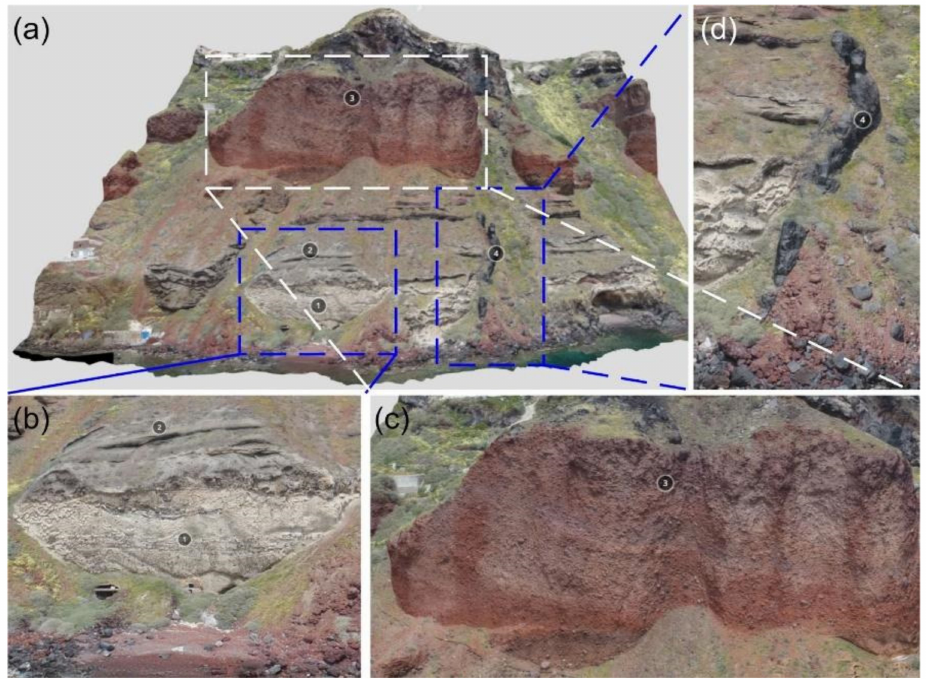
Figure 11. ( a ) A northern caldera wall outcrop close to the Oia village. ( b ) A closer look of the contact between the rhyodacitic pyroclastic deposits and the less evolved ones (andesitic to dacitic), ( c ) a view towards the north of the US2 deposit, and ( d ) a basaltic andesitic dike with a variable dip that dissects the products of the second explosive